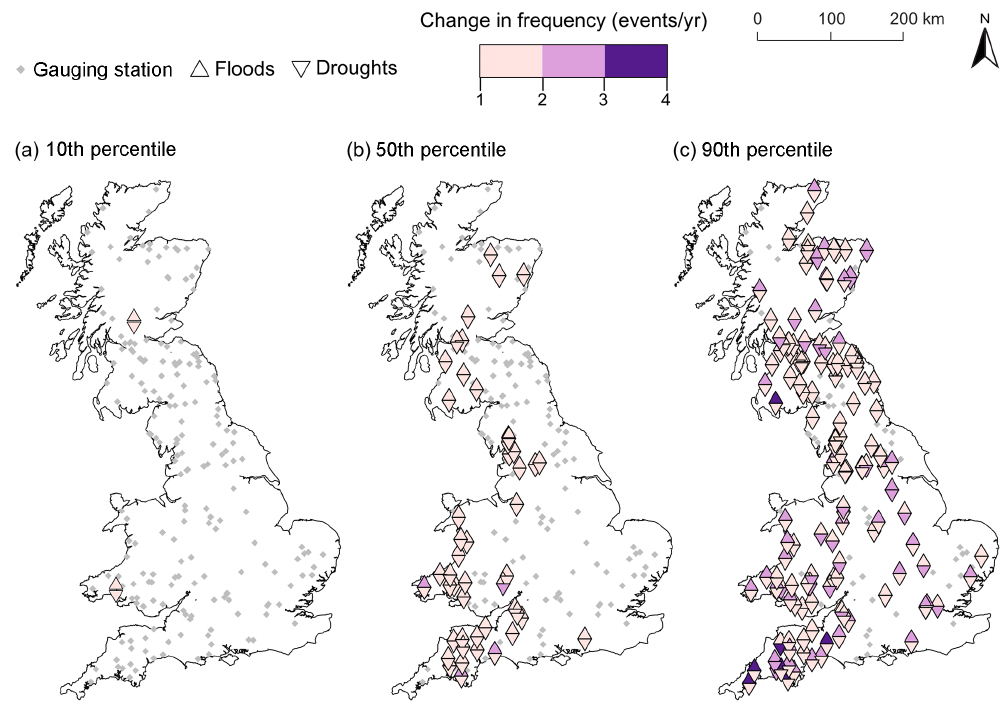
Figure 5. Changes in frequency of the hydro-hazards for the hot-spots in Great Britain for the (a) 10th, (b) 50th, and (c) 90th percentiles.